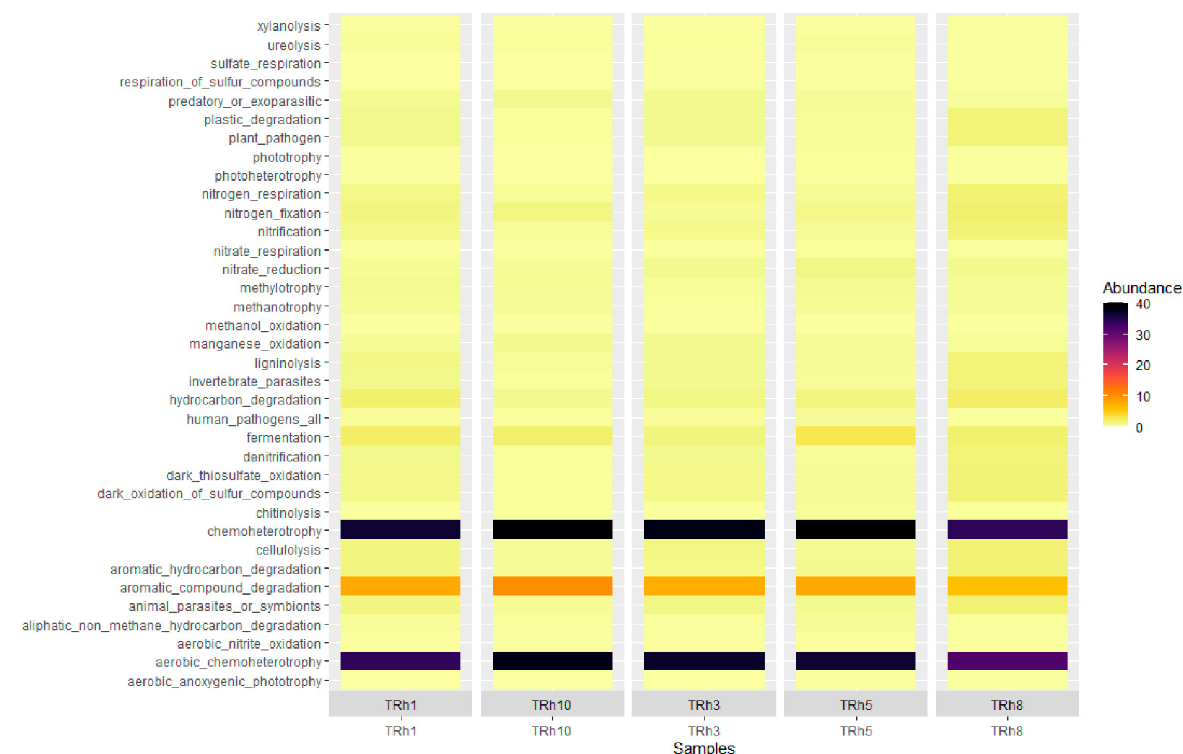
Figure A1. Heatmap shows all functions of bacteria predicted by FAPROTAX. The data based on OTUs abundance derived from rhizosphere soil samples (TRh) of red clover ( Trifolium pratense ).